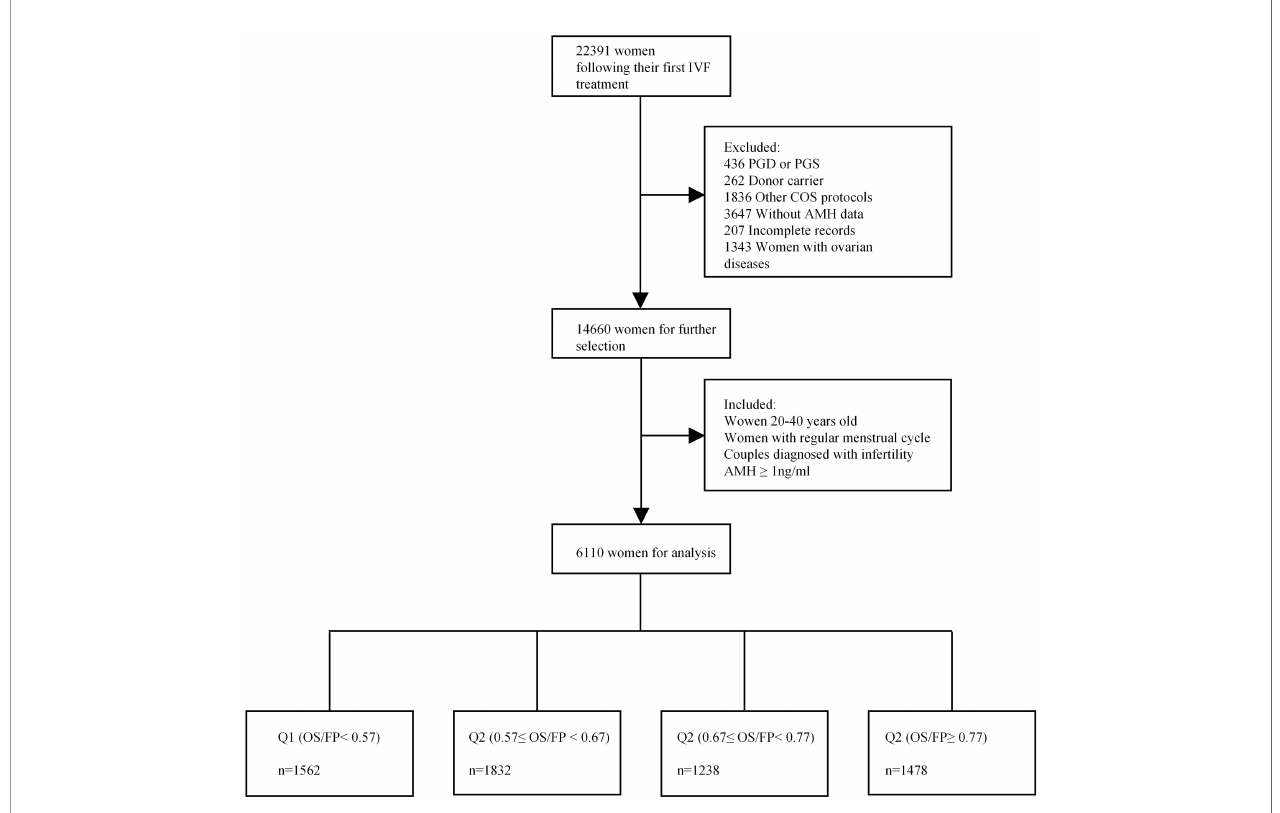
FIGURE 1 | A fl owchart of data preparation for